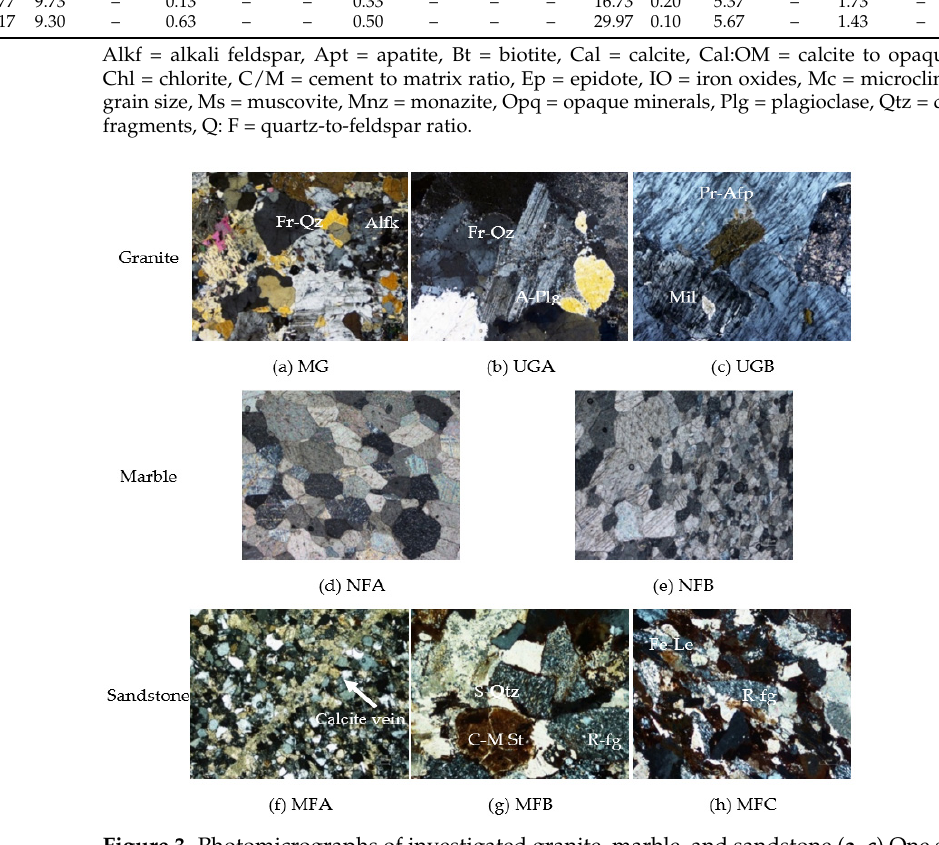
Figure 3. Photomicrographs of investigated granite, marble, and sandstone ( a – c ) One set of cleavages are observed in UGA and UGB samples, Fr-Qz: fractured quartz, Alfk: alkali feldspar, A-Plg: altered plagioclase, Pr-Afp: perthite alkali feldspar, Mil: microcline ( d , e ) calcite-rich marble in NFA and NF B ( f – h ) fractures are seen in MFA and MFC samples, C-M St: clay rich mudstone, R-fg: volcanic rock fragments, Fe-Le: iron